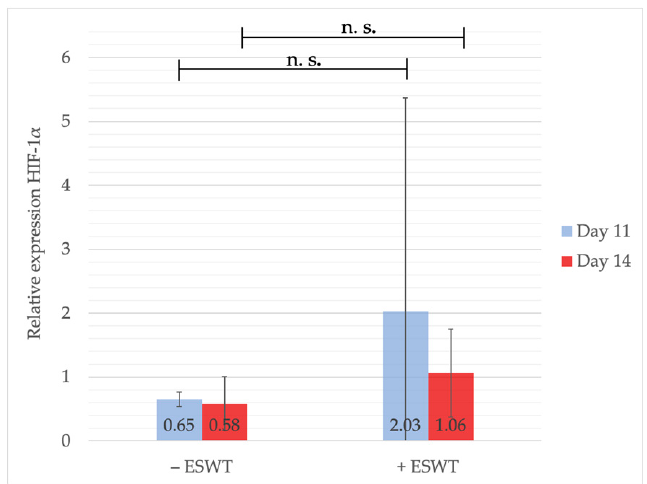
Figure 6. Gene expression analysis of HIF-1 α via qPCR. Measurements were performed on EDD-11 and EDD-14, i.e., one and four days after ESWT or sham treatment. Although there was no statistically significant difference detectable, the analysis showed a slight increase of HIF-1 α expression one day after ESWT compared to the control group, whereas no di ff erence could be shown on EDD-14. Shown are means ± SD, n.s. = not significant. EDD-11: Independent-Samples T-Test between experimental groups and untreated control, normally distributed, homogeneity of variance. EDD-14: Mann-Whitney test, not normally distributed. Abbreviations: qPCR—quantitative polymerase chain reaction; HIF-1 α —Hypoxia-inducible factor α .